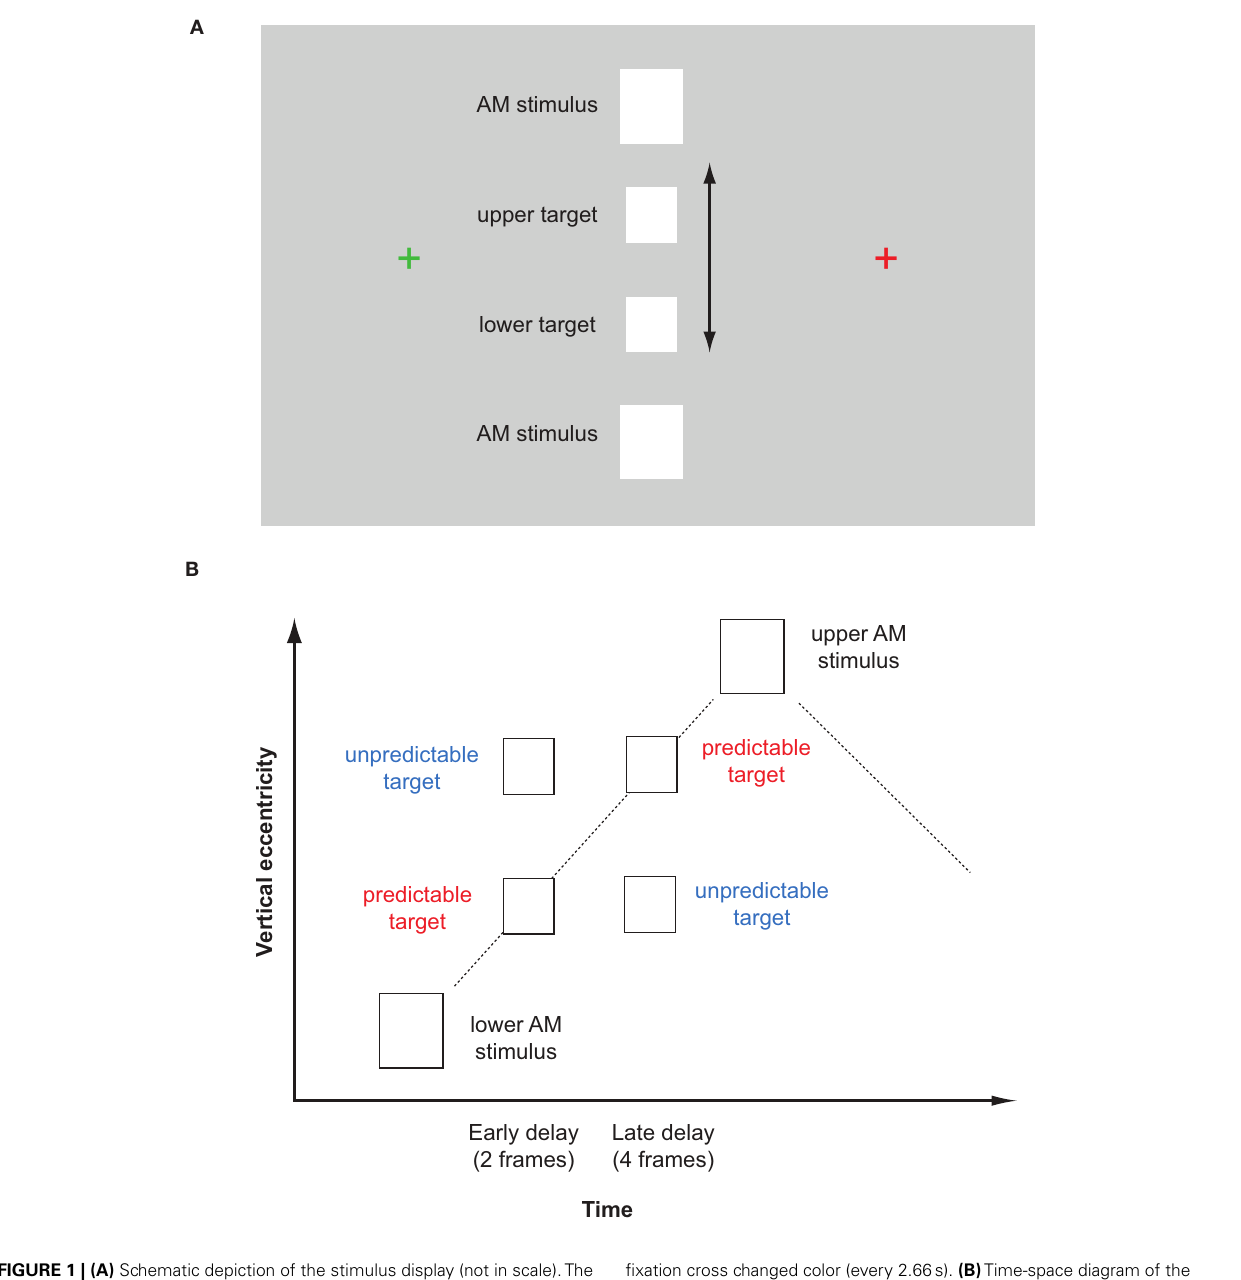
fixation cross changed color (every 2.66s). (B) Time-space diagram of the stimulus display. Predictable targets were flashed in-time with a linearly moving illusory token whereas unpredictable targets were flashed out-of-time with an illusory token, i.e., at the same time as the corresponding predictable target but at the wrong place.Targets were presented either at an early or late delay, and either during upward or downward apparent